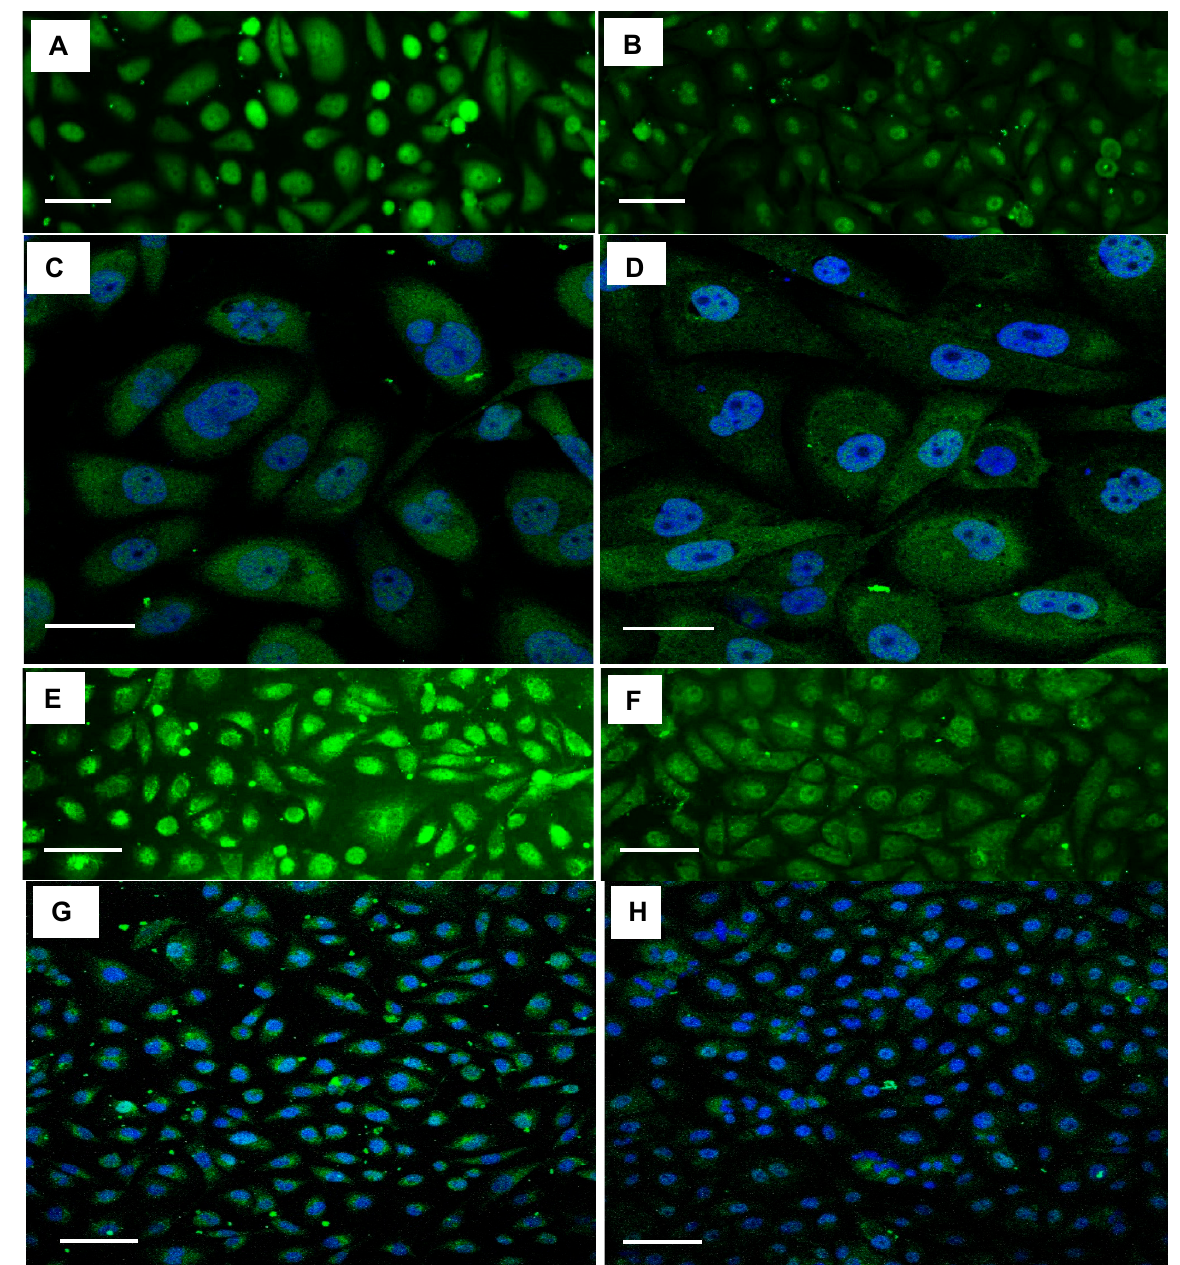
Figure 2. SBT-100 reduces intracellular levels of both phosphorylated and total STAT3. Confocal fluorescent microscopy demonstrates SBT-100 decreases intracellular levels of total (t) STAT3 in MDA-MB-231 cells, with the nuclei detection with DAPI. Fluorescent images of tSTAT3 in MDA-MB-231 cells, either untreated ( A ) or following 6 h of SBT-100 treatment (150 µg/mL) ( B ). Confocal images of tSTAT3 in MDA-MB-231 cells, either untreated ( C ) or following 6 h of SBT-100 treatment (150 µg/mL) ( D ), both with the nuclei detection with DAPI. Confocal fluorescent microscopy demonstrates SBT-100 decreases intracellular levels of phosphorylated (p) STAT3 in MDA-MB-231 cells, with the nuclei detection with DAPI. Fluorescent images of pSTAT3 in MDA-MB-231 cells, either untreated ( E ) or following 6 h of SBT-100 treatment (150 µg/mL) ( F ). Confocal images of pSTAT3 in MDA-MB-231 cells, either untreated ( G ) or following 6 h of SBT-100 treatment (150 µg/mL) ( H ), both with the nuclei detection with DAPI. The scale bars in the lower-left corner of each panel represent 100 µm.